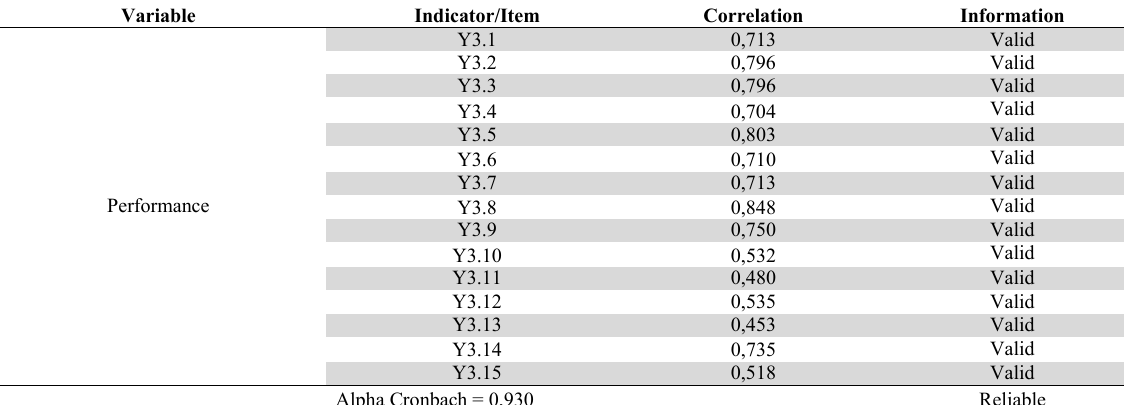
Validity and Reliability Test for Performance